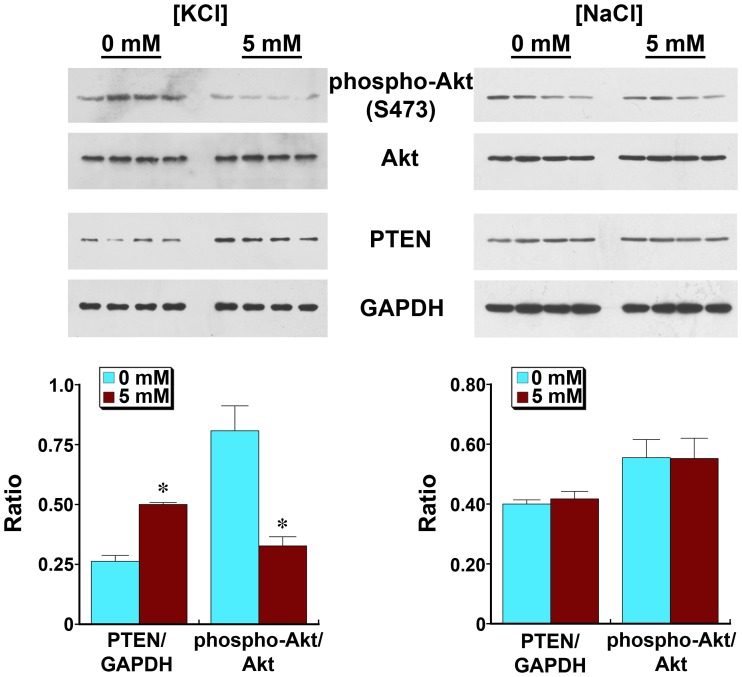
Ambient potassium chloride, but not sodium chloride, regulates PTEN levels and Akt function in endothelial cells.Macrovascular endothelial cells (HUVEC) were incubated overnight in medium containing [KCl] at 0 and 5 mM (left panel) or in medium containing [KCl], 0 mM, supplemented with 0 or 5 mM [NaCl] (right panel). Compared to cells incubated in medium lacking KCl, cells incubated in medium containing 5 mM KCl demonstrated less phospho-Akt(S473) and more PTEN, relative to GAPDH. In contrast, overnight incubation in medium supplemented with NaCl instead of KCl did not alter intracellular PTEN or phospho-Akt(S473). Each lane represents data from a single experiment.